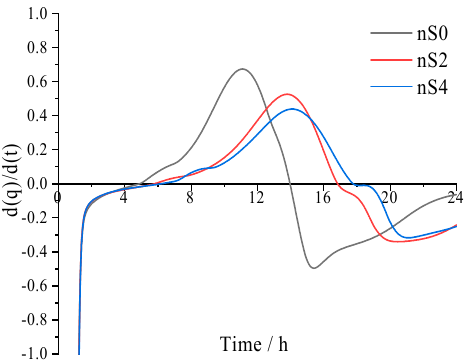
Figure 3. A typical curve of first derivative of the heat evolution curve (d(q)/d(t)).